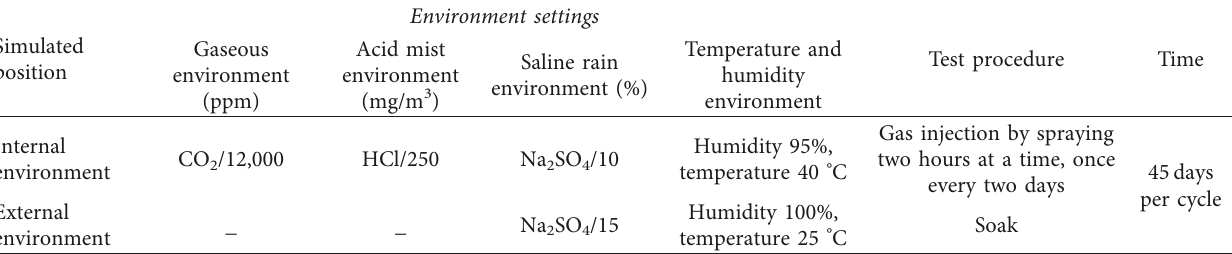
Table 2: Settings for simulation of the natural environment inside and outside shaft lining.